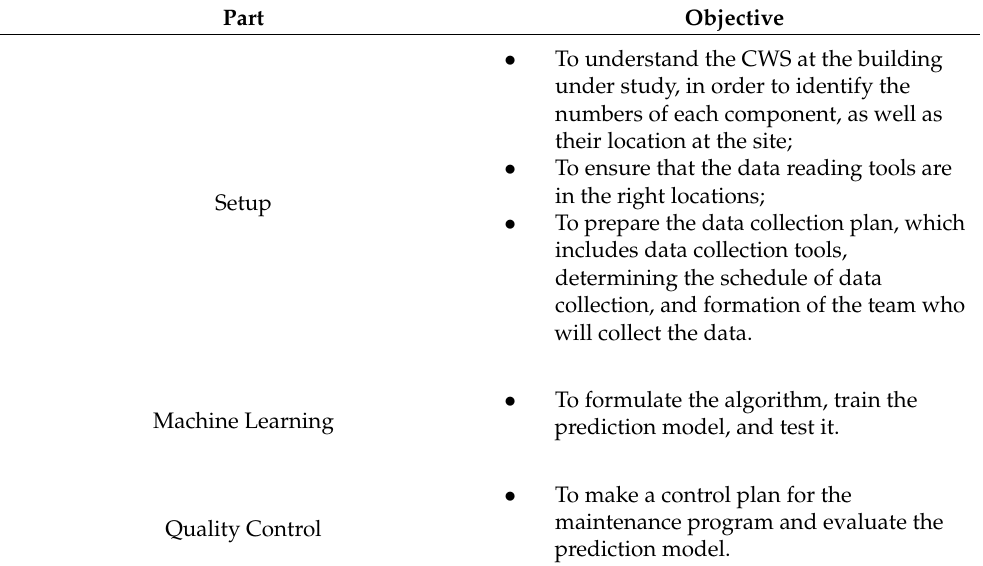
Table 2. Framework